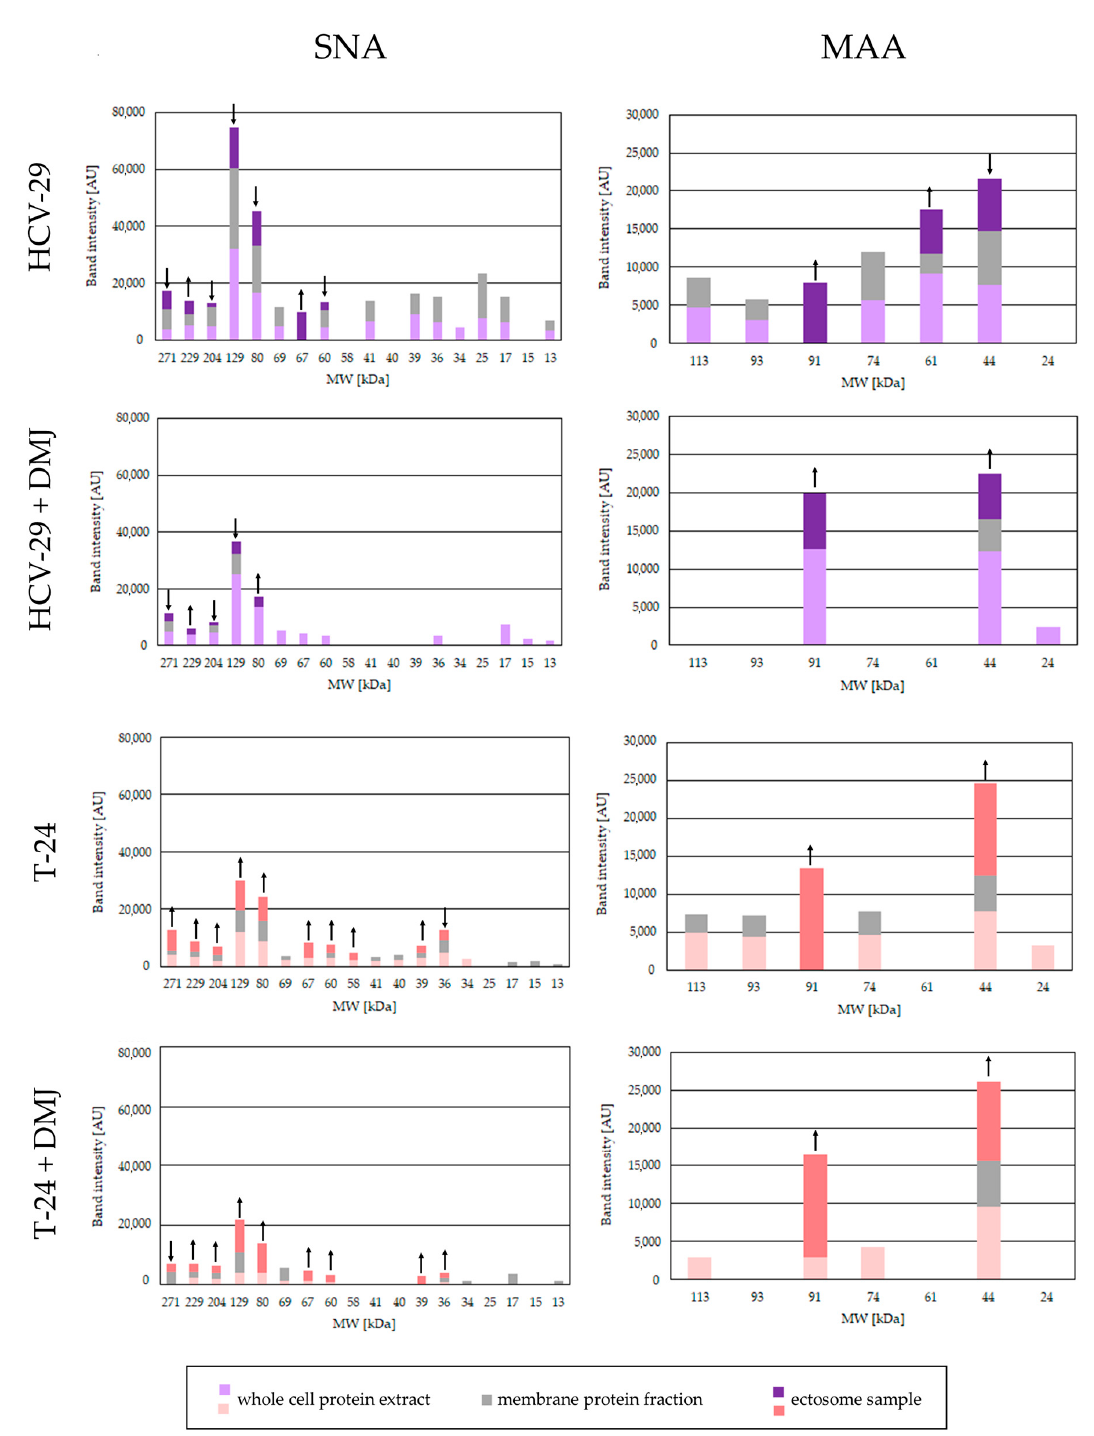
Figure 6. Densitometric analysis of SNA- and MAA-positive bands. The intensity of detected bands was expressed in arbitrary units (AU) as a peak area on respective densitogram. Each bar represents the intensity of corresponding bands in the whole cell protein extracts, membrane fractions and ectosome samples from each cell line. ↑ and ↓ denote a significant enrichment or depletion, respectively, of a given glycoepitope in the ectosomal fraction compared to membrane fraction. The values from control lectin blots with blocking solutions were subtracted